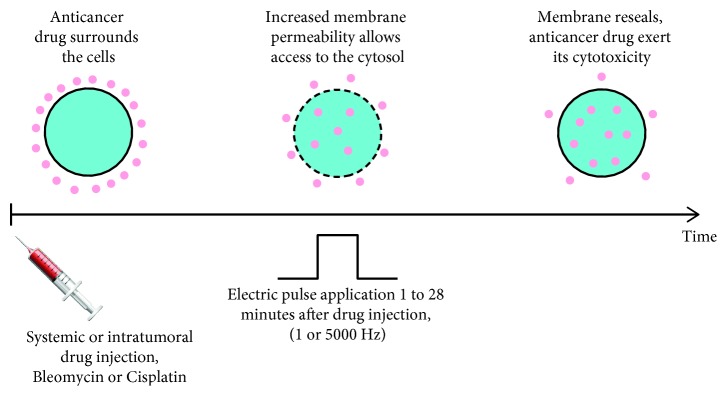
Principle of ECT.